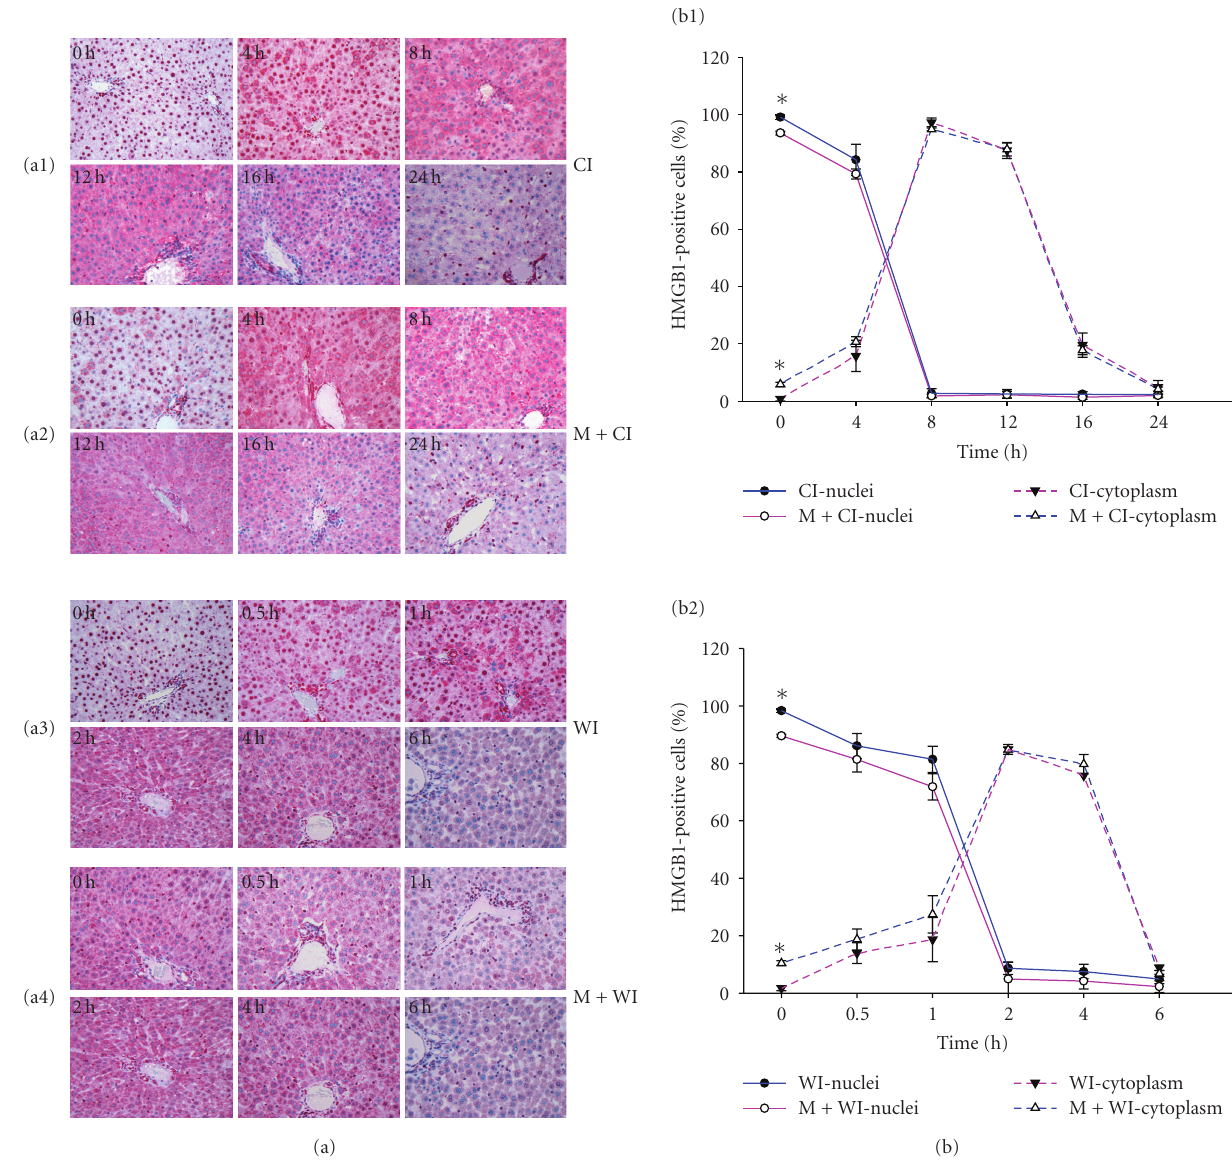
Figure 3: Immunohistochemical analysis of HMGB1 expression in rat livers following cold/warm ischemia. Staining pattern changed upon ischemia and mechanical stress (a). (a1) cold ischemia (CI), (a2) mechanical stress plus cold ischemia (M+CI), (a3) warm ischemia (WI), (a4) mechanical stress plus warm ischemia (M+WI). Relative frequency of hepatocytes with nuclear and cytoplasmic staining (b). In normal liver, only single hepatocytes showed cytoplasmic staining ( < 1%). The relative frequency increased with ischemia time and reached a peak after 2 h/8h (85%/95%) of warm/cold ischemia and decreased continuously thereafter. Mechanical stress inflicted on the liver during explantation increased HMGB1 translocation ( P < . 05 versus without mechanical stress groups). Data shown are representative of all tissue samples analyzed at a magnification of 200x. ∗ P < .